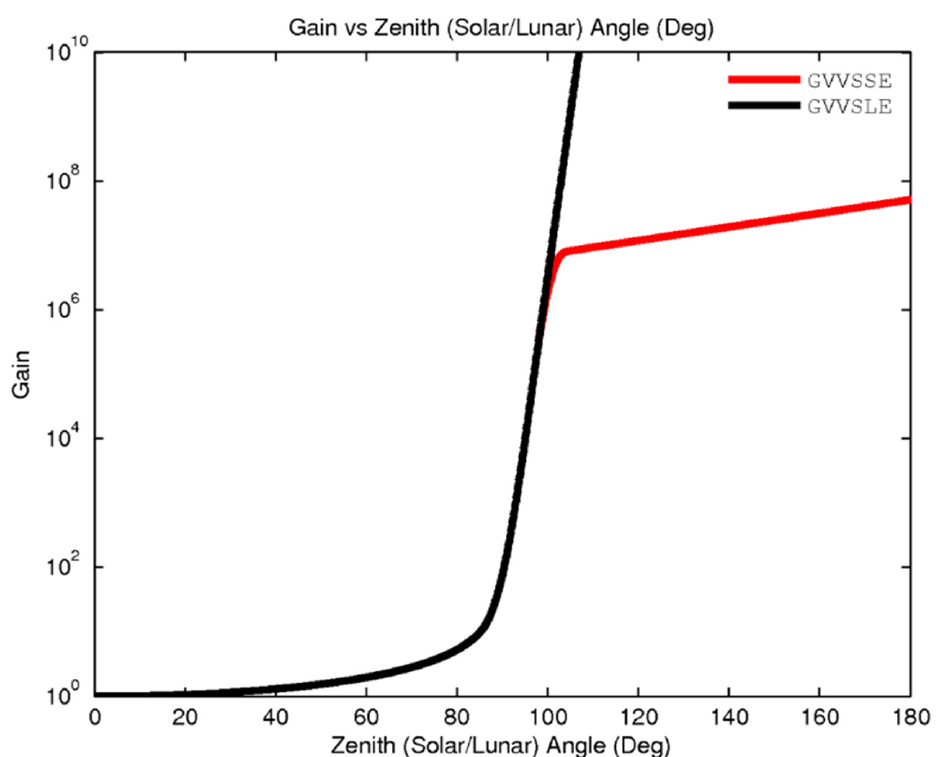
Figure 3. NCC LUT as expanded from the original cutoff at 105 ◦ zenith angle, beyond which the NCC had consisted of fill values. The LUT up to 105 ◦ is represented in the chart by the black, GVVSLE curve. Now, with the low radiances of airglow accounted for, the NCC produces imagery for zenith angles from 105 ◦ to 180 ◦ , for coverage under no-moon lighting conditions, which is represented in the graph by the red, GVVSSE curve.